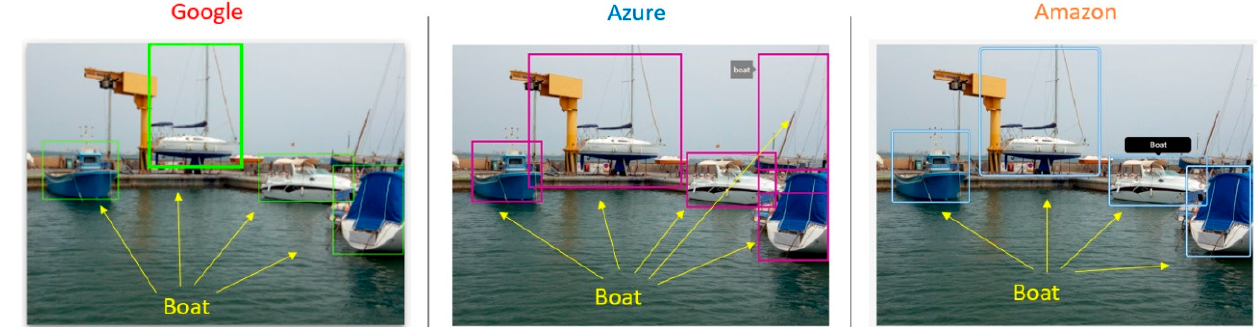
Figure 5. Comparison of three different clouds vision API detection of boats in Los Nietos port (Murcia, Spain).